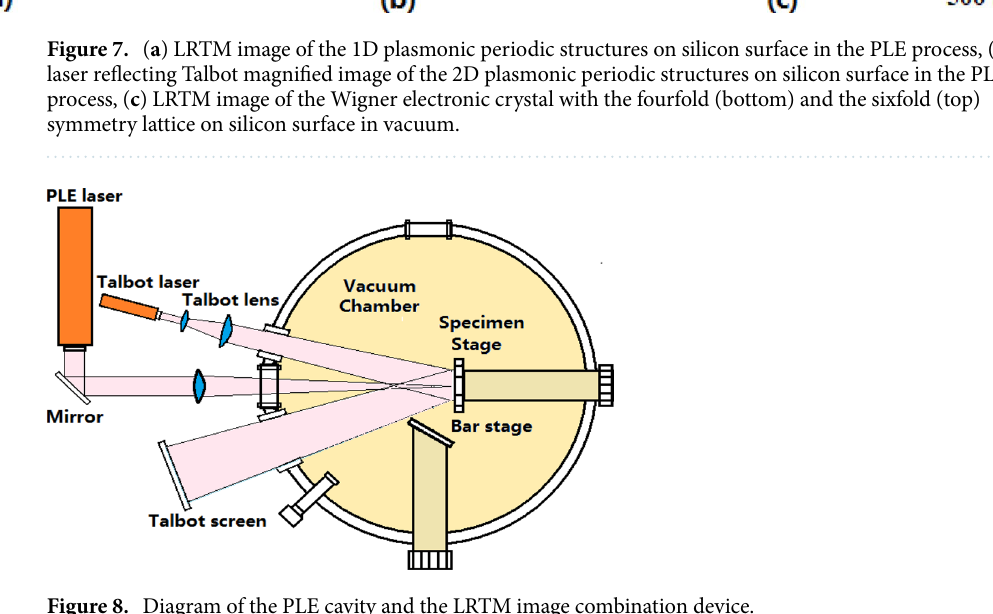
Figure 8. Diagram of the PLE cavity and the LRTM image combination